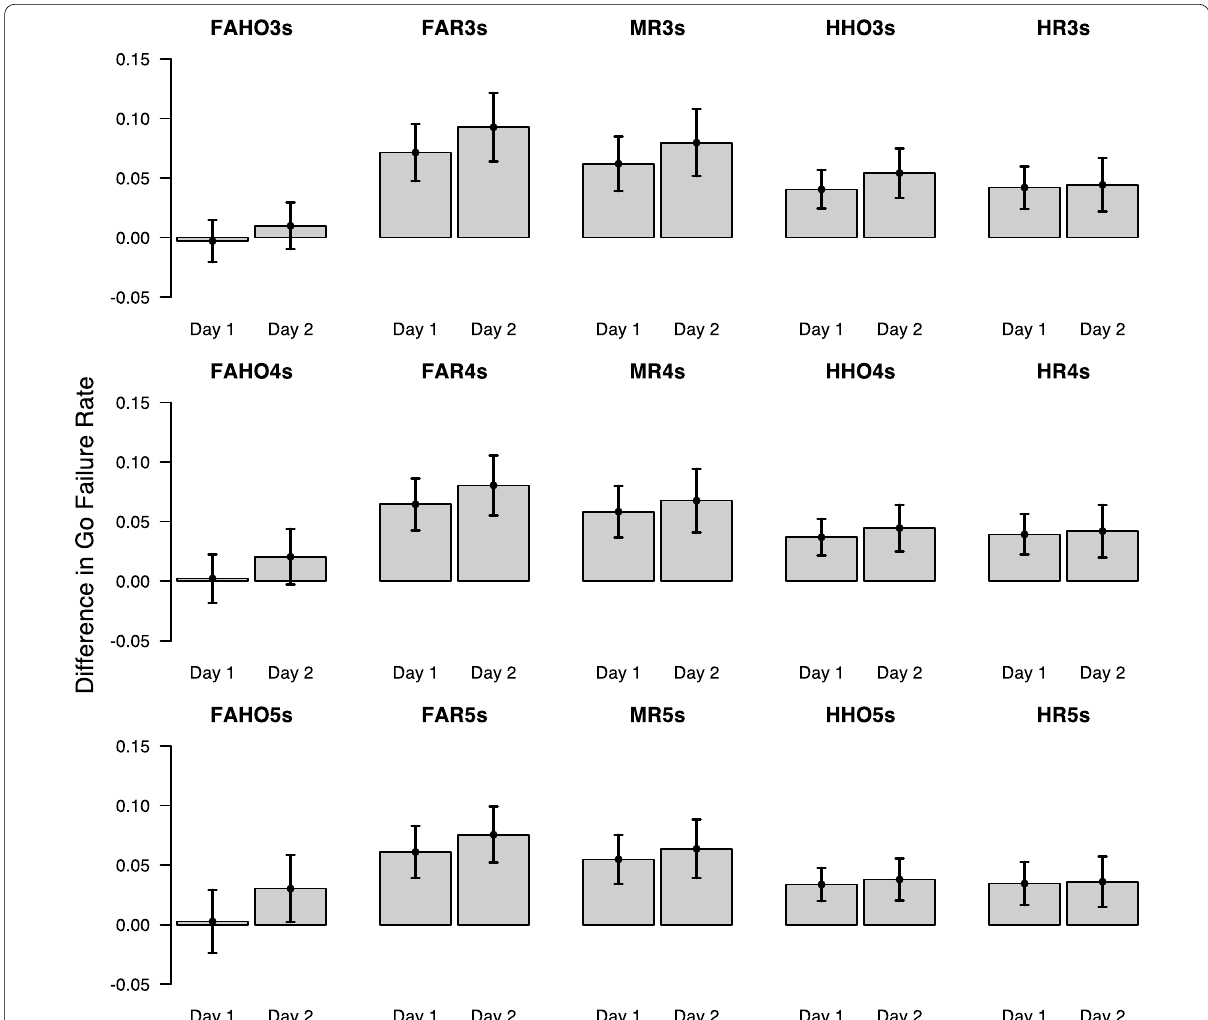
Fig. 6 Effect of different UAV events on omissions for different time windows prior to the DRT prompt. Top row: 3-s time window; middle row: 4-s time window; bottom row: 5-s time window. Error bars show mean difference